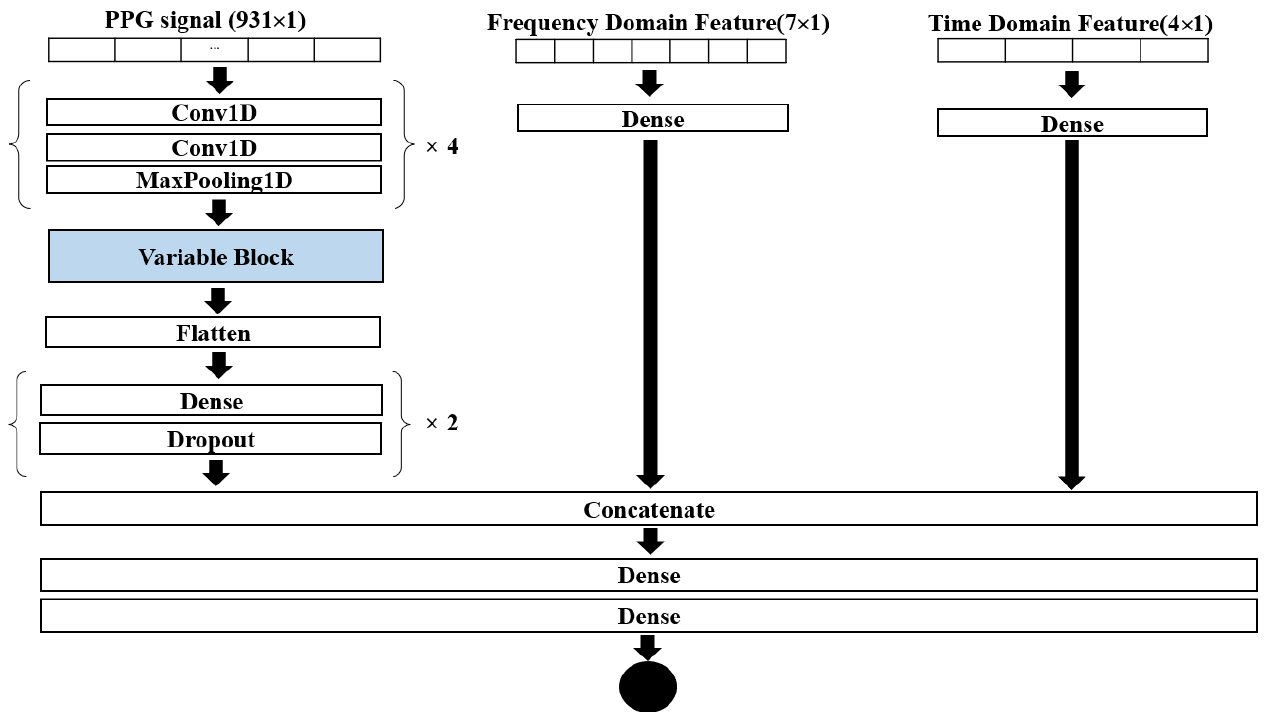
Figure 3. The overall architecture of the proposed deep learning model.